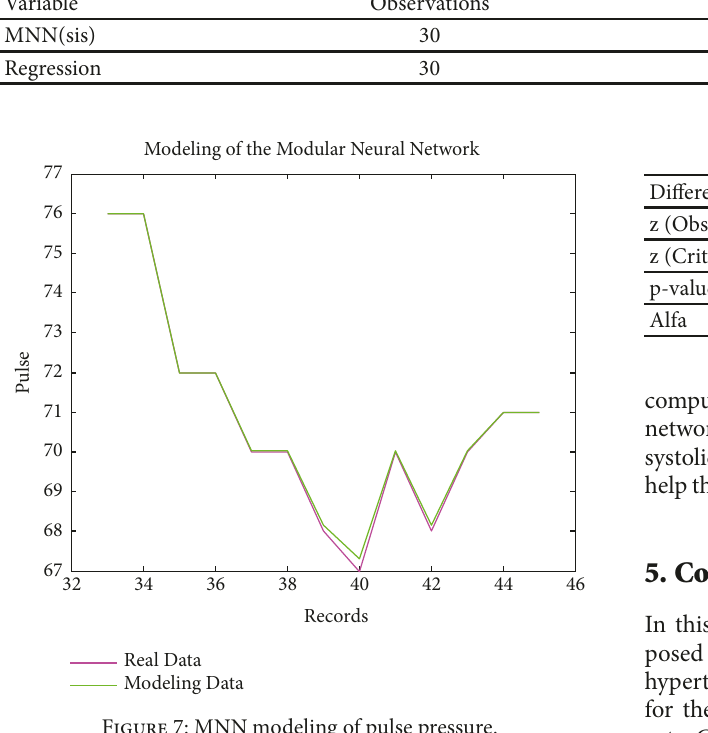
Figure 7: MNN modeling of pulse pressure.